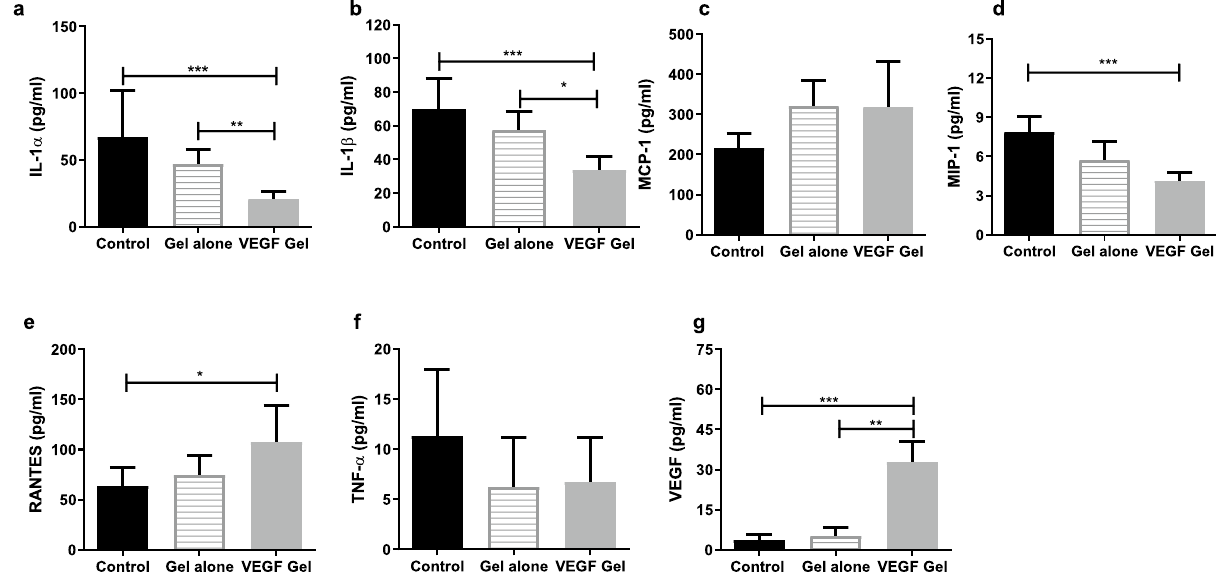
Figure 8. Plasma cytokine levels showed a statistically significant modulation in the VEGF-gel group. IL-1α ( a ), IL-1β ( b ), MCP-1 ( c ), MIP-1 ( d ), RANTES ( e) , TNF-α ( f ) and VEGF ( g ) (***p < 0.001, **p < 0.01, *p <